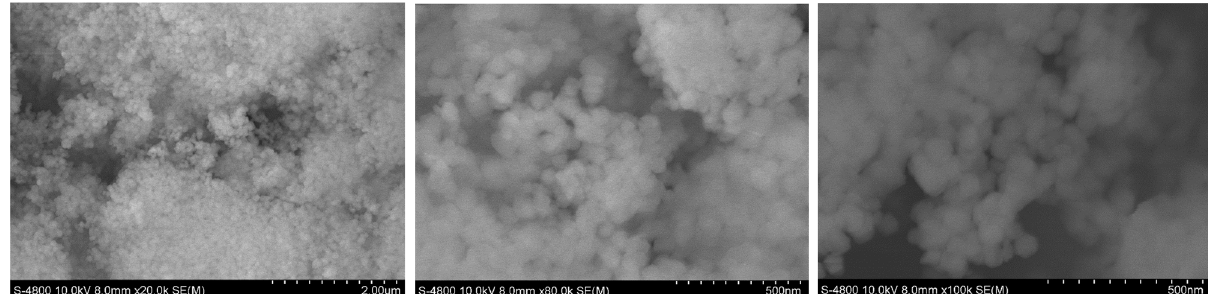
Figure A2: SEM images of CuCo - ZIFs at di ff erent magni fi cation ratios: ( a ) 20,000 × , ( b ) 80,000 × , and ( c ) 100,000 × .